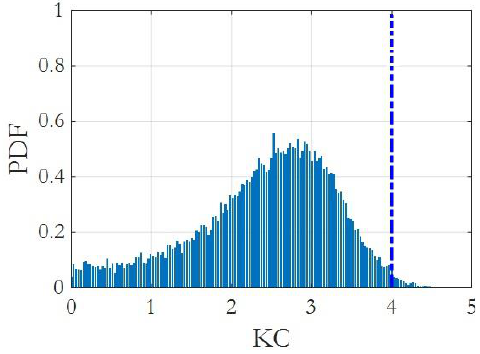
Figure 11. Probability distribution of KC.